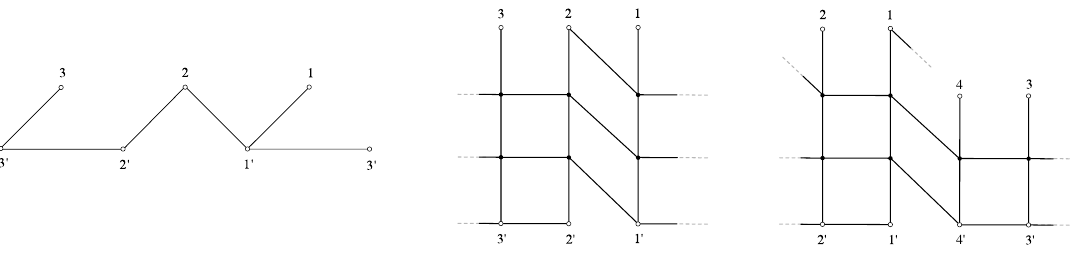
Figure 18 . Left: reduction at the point u → − 1 / 2 of the kernel of the transfer matrix operator t ( a ) ( u ) for a spin chain of length L = 3 , for auxiliary and physical spaces in the representation of zero spins ‘ = ‘ = 0 , ˙ ‘ = ˙ ‘ = 0 and scaling dimensions ∆ a k a k tive composition of the reduced transfer matrix is the graph-builder of the bulk of Feynman integrals contributing to the two point function of Tr (cid:2) φ 2 (cid:3) , corresponding to the term for the graphs of Tr (cid:2) φ 3 φ 2 1 top of the graph is ˆ B 0 while the second and third are ˆ B 0 2